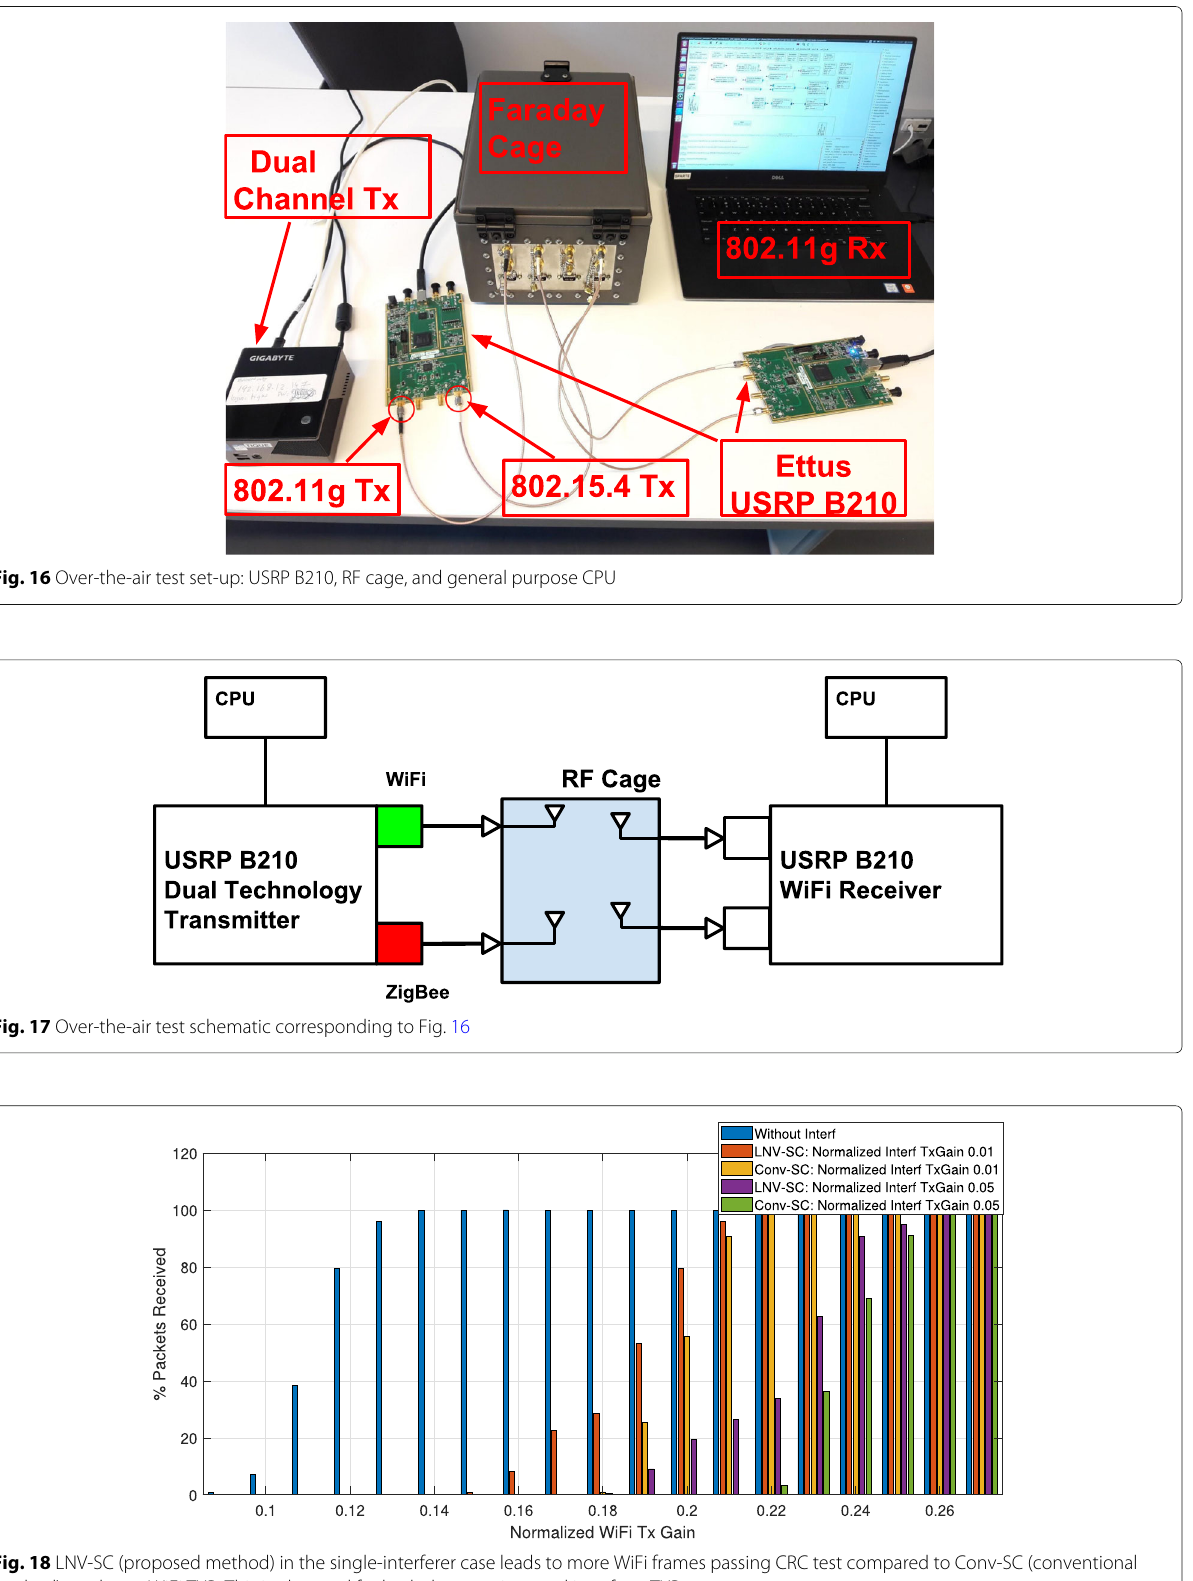
Fig. 18 LNV-SC (proposed method) in the single-interferer case leads to more WiFi frames passing CRC test compared to Conv-SC (conventional method) at a lower WiFi TXP. This is observed for both the experimented interferer